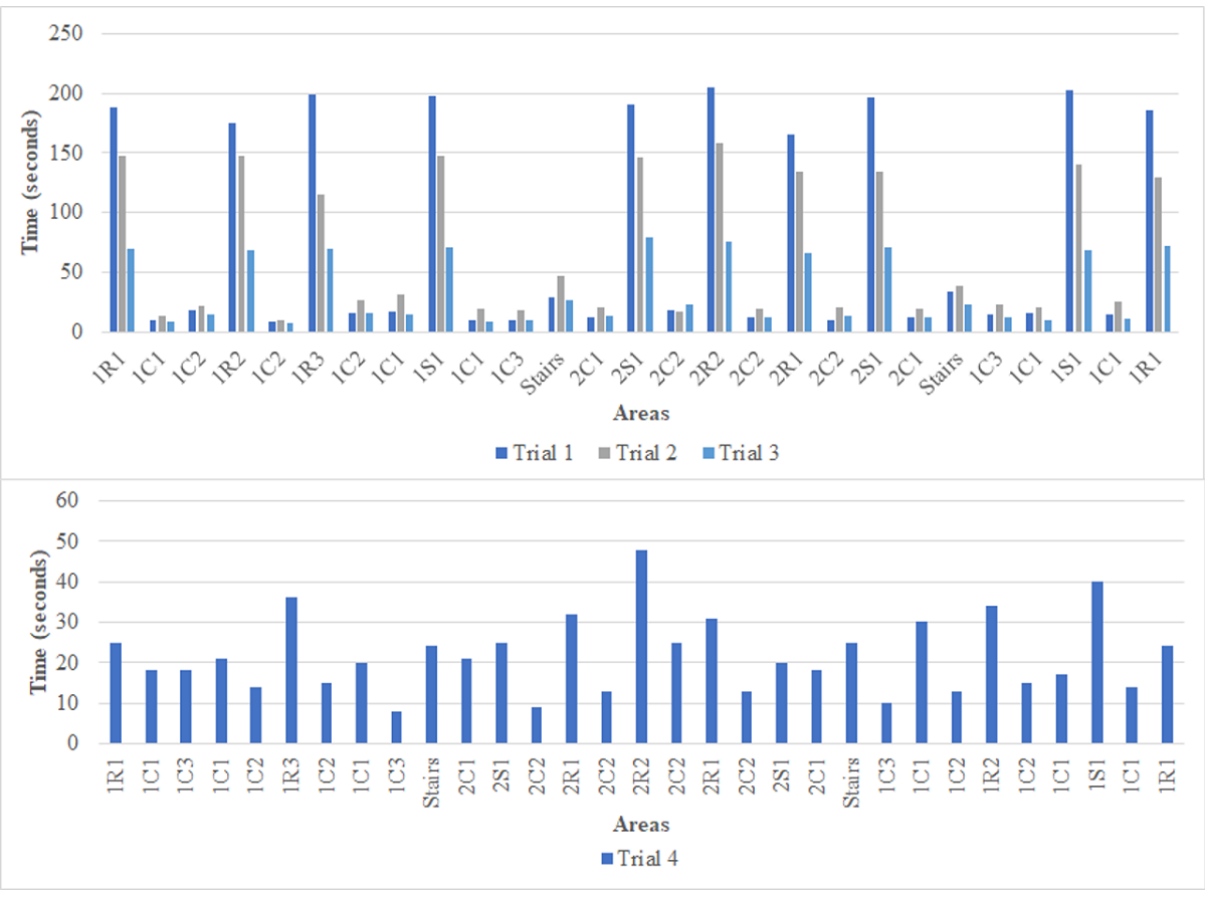
Figure 1. A visual representation, based on the areas order, of the dwelling time for each trial. Trial 1 at normal walking speed (self-paced at approximately 1.4 m/s); Trial 2 at slow walking speed (self-paced at approximately 0.9 m/s or slower); Trial 3 at fast walking speed (self-paced at approximately 2.0 m/s); Trial 4, the walking speed, dwelling time and route were not prescribed (ie, not previously decided). The locations are named as follows: First number indicates the floor: "1" indicates the first floor and "2" indicates the second floor; Uppercase letter indicates the type of room where the beacon was installed: "S" indicates a social area, "R" indicates a standard room, "C" indicates a corridor; Second number is a counter for the same type of room on the same floor; Lowercase letter is used only for long corridors or a large social area to indicate when multiple beacons were used; The label “Stairs” indicates the beacon placed in the stairway (same beacon on both